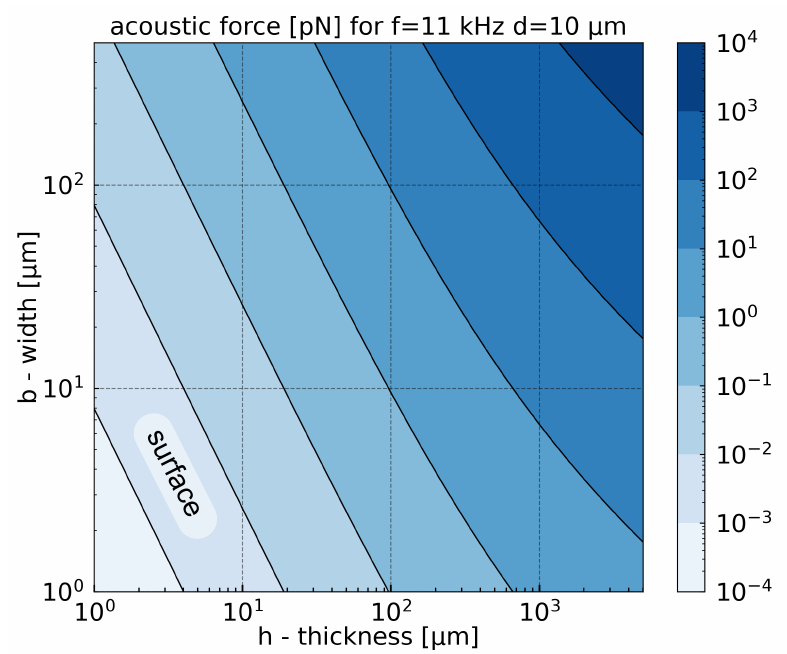
Figure 4. Acoustic force for 1% of CH 4 in N 2 as a function of width b and thickness h of the cantilever. For different thickness, the length is adjusted to maintain constant frequency: 11 kHz. This frequency was chosen to maximize acoustic force. The area with the weakest acoustic force corresponds to cantilevers with the smallest